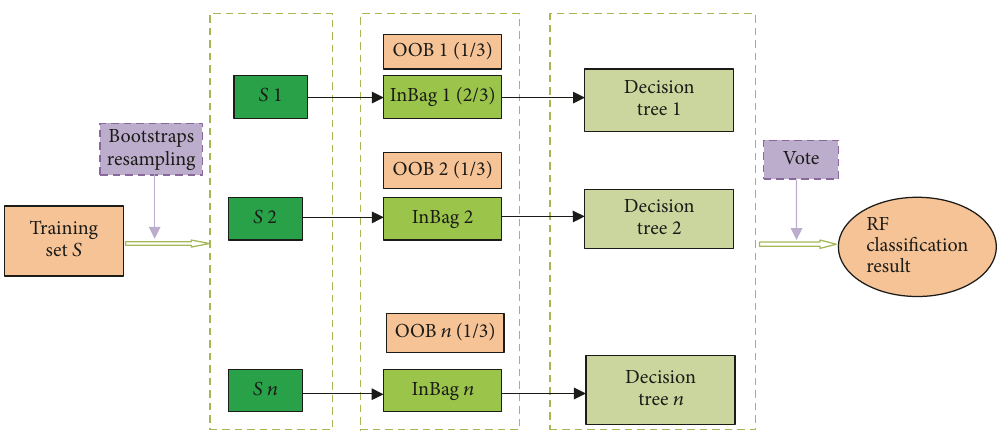
Figure 1: The flow chart of